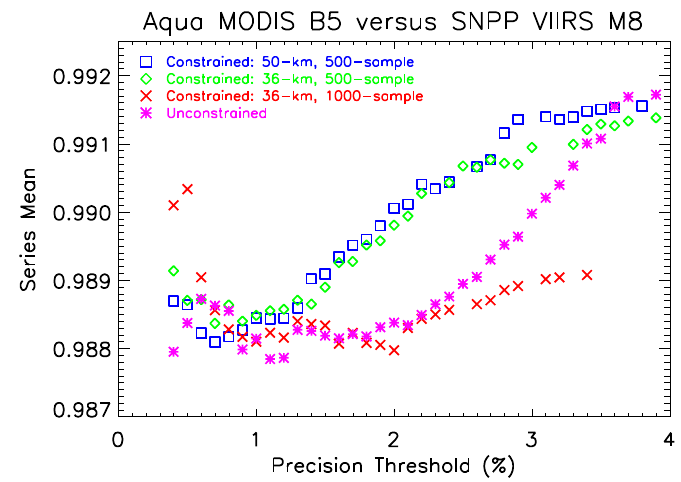
Figure 12. The mean of the radiometric comparison time series at each level of precision threshold, for the constrained and the unconstrained cases in Aqua MODIS B5 versus SNPP VIIRS M8.